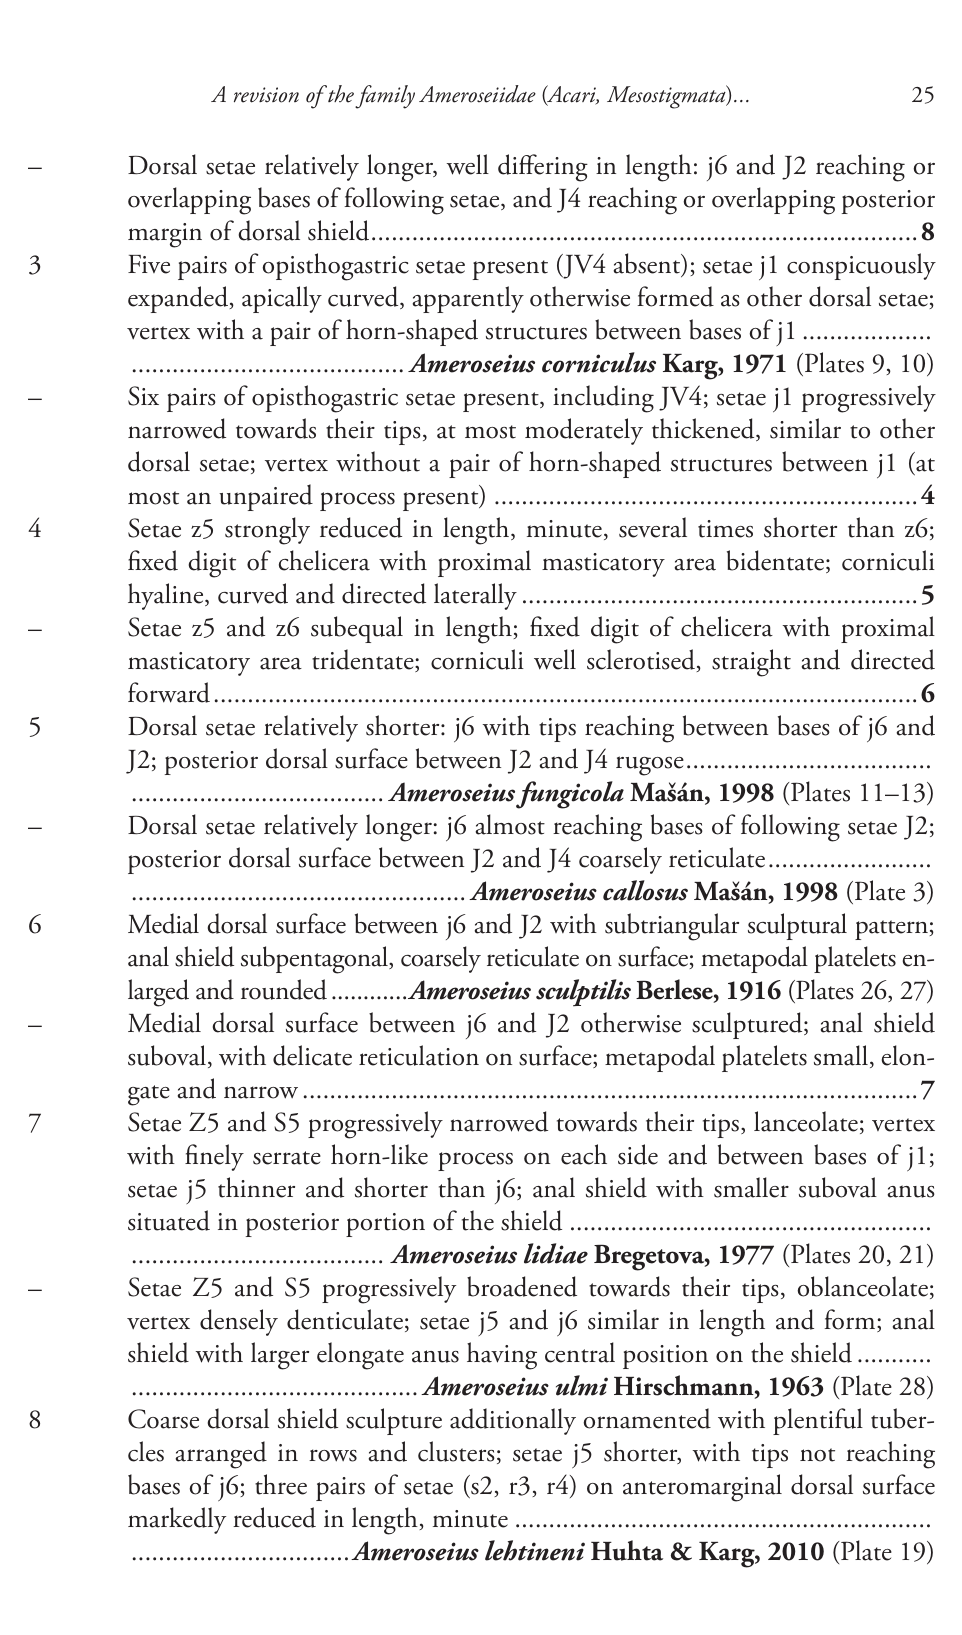
– Setae Z5 and S5 progressively broadened towards their tips, oblanceolate; vertex densely denticulate; setae j5 and j6 similar in length and form; anal shield with larger elongate anus having central position on the shield ........... 8 Coarse dorsal shield sculpture additionally ornamented with plentiful tuber- cles arranged in rows and clusters; setae j5 shorter, with tips not reaching bases of j6; three pairs of setae (s2, r3, r4) on anteromarginal dorsal